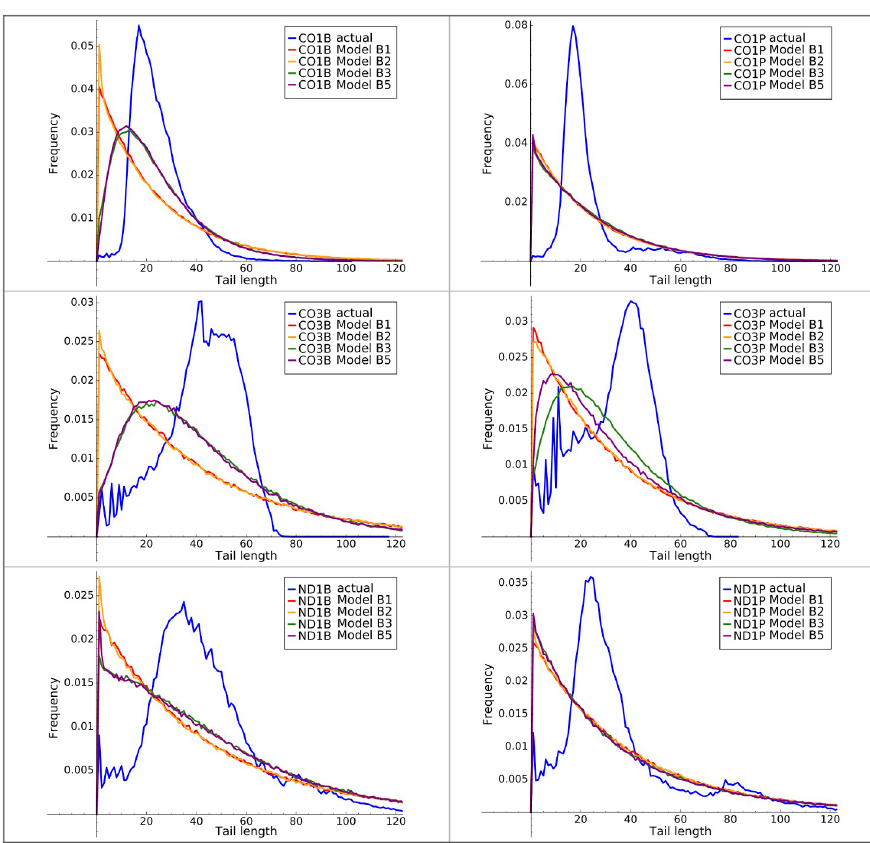
Fig 10. Actual and model tail length distributions. Observed and model output tail length distributions using B- series HMMs of all tested complexity levels.